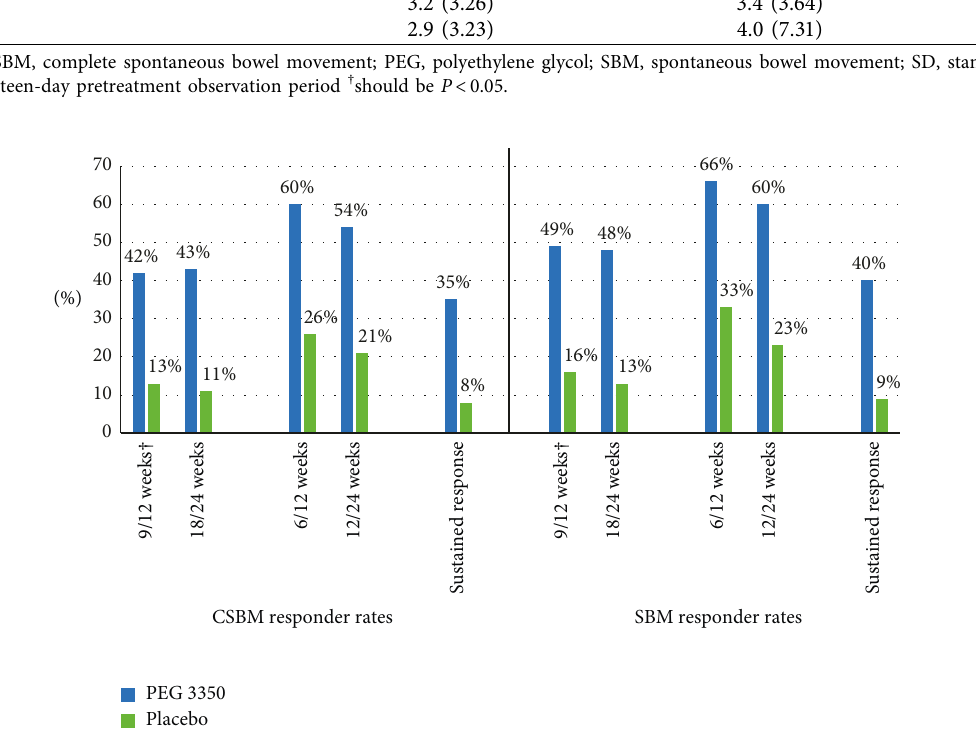
Figure 1: CSBM and SBM response rates using different time intervals. Abbreviations: CIC, chronic idiopathic constipation;